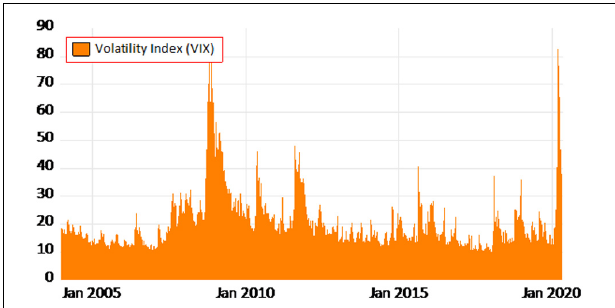
FIGURE 2 | Variations in VIX due to Global Financial Crisis 2007–2009 and COVID-19